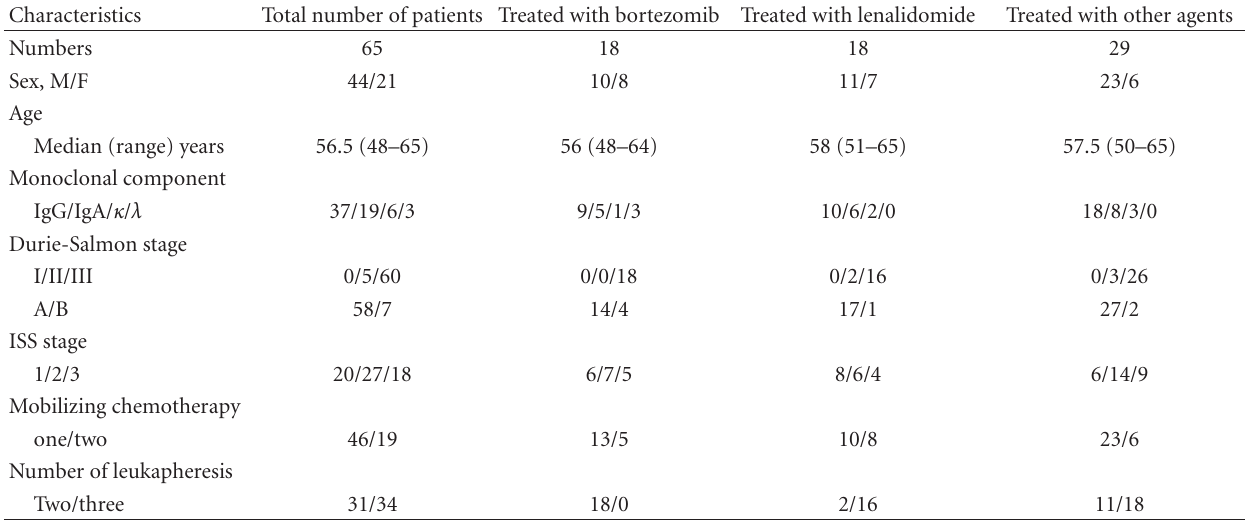
Table 1: Patients’